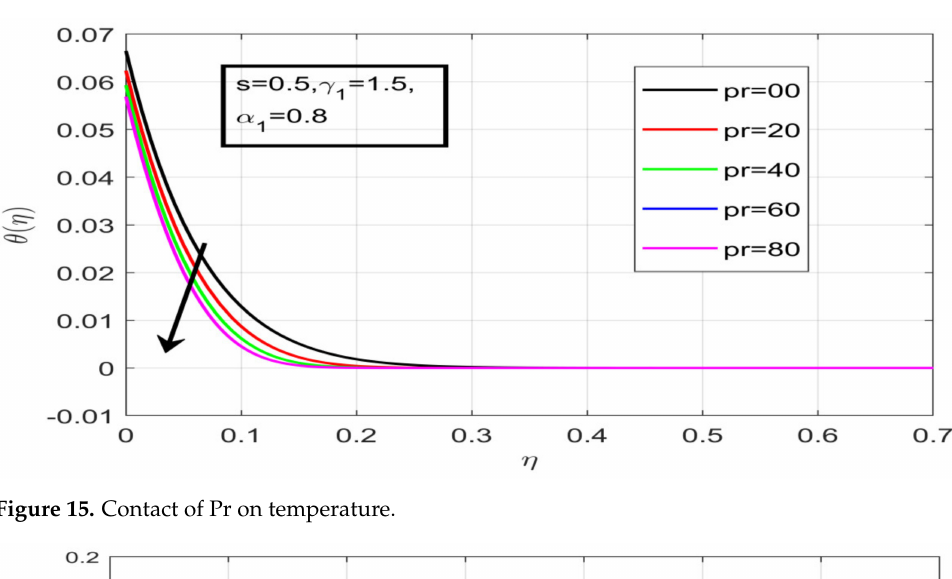
Figure 14. Variation in N_T on temperature.